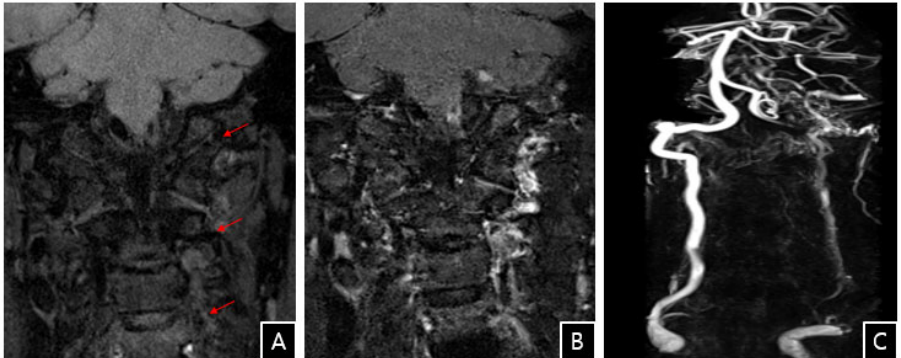
Figure 3. ( A – C ) Coronal T1 ‐ weighted and enhanced MR and MR angiography images demonstrate occlusion of vertebral artery with eccentric wall thickening in the left distal V2, V3, and V4 segments and strong enhancement with mural thrombus in those segments (arrows). Magnetic resonance an ‐ giography demonstrated occlusion of the left VA and dissection of the left V2–V4 segments (Figure 3). Extraluminal pathology compressing the left distal VA was also noted. Thrombolysis was not